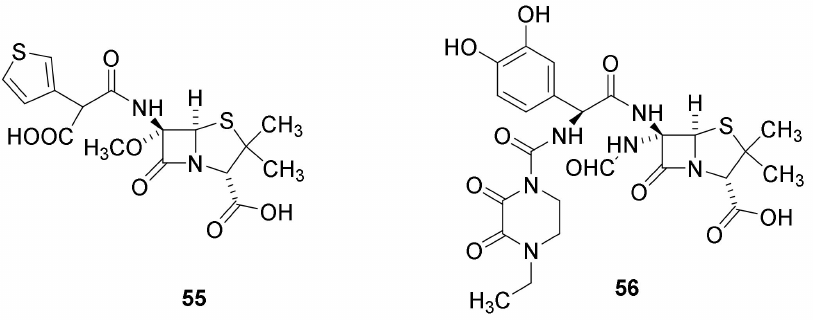
Figure 12. Temocillin ( 55 ) and formadicillin ( 56 ) [44]. Temocillin is approved by European Medicine